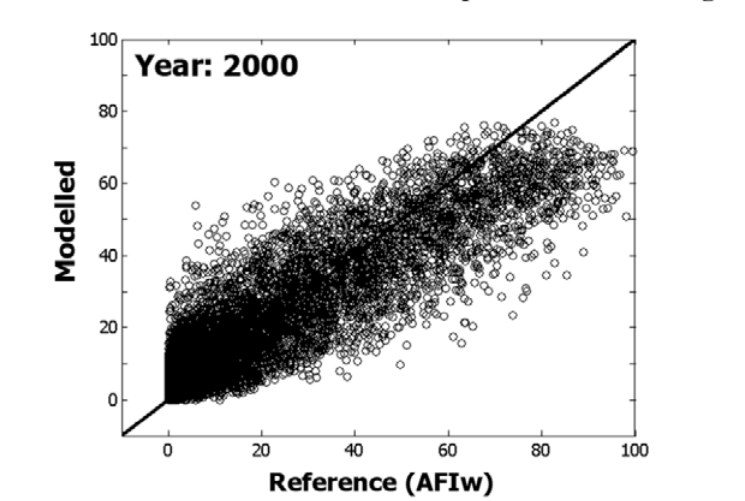
Figure 8. Scatterplot between reference winter crop abundances (AFIw) of Tuscany at 1 km scale (x-axis) and modeled results (y-axis). The modeled results were obtained in a leave-one-out approach. For the corresponding statistics the reader is referred to Table